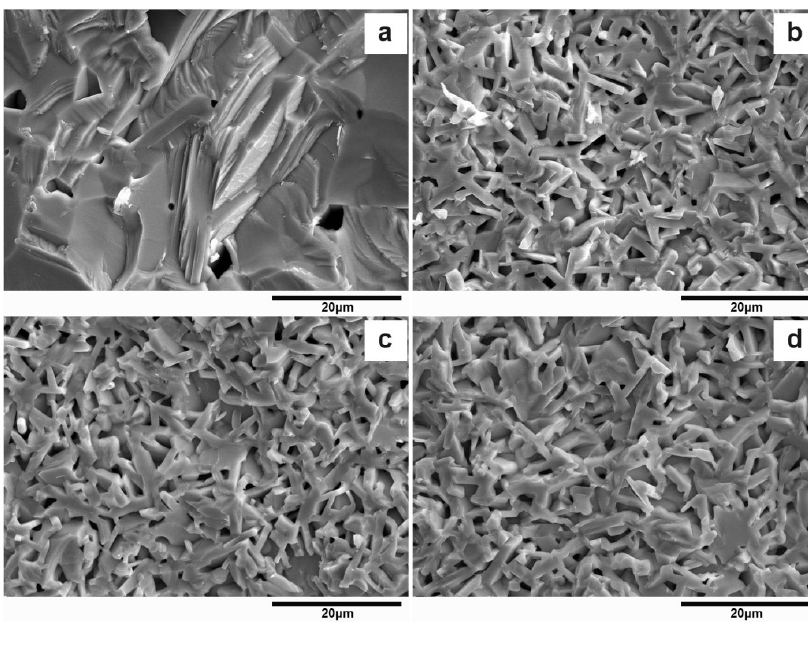
Figure 9. SEM cross-section morphology of La ( a ) 5.27 g/cm 3 ; ( b ) 4.63 g/cm 3 ; ( c ) 4.41 g/cm 3 ; ( d ) 4.25 g/cm 3